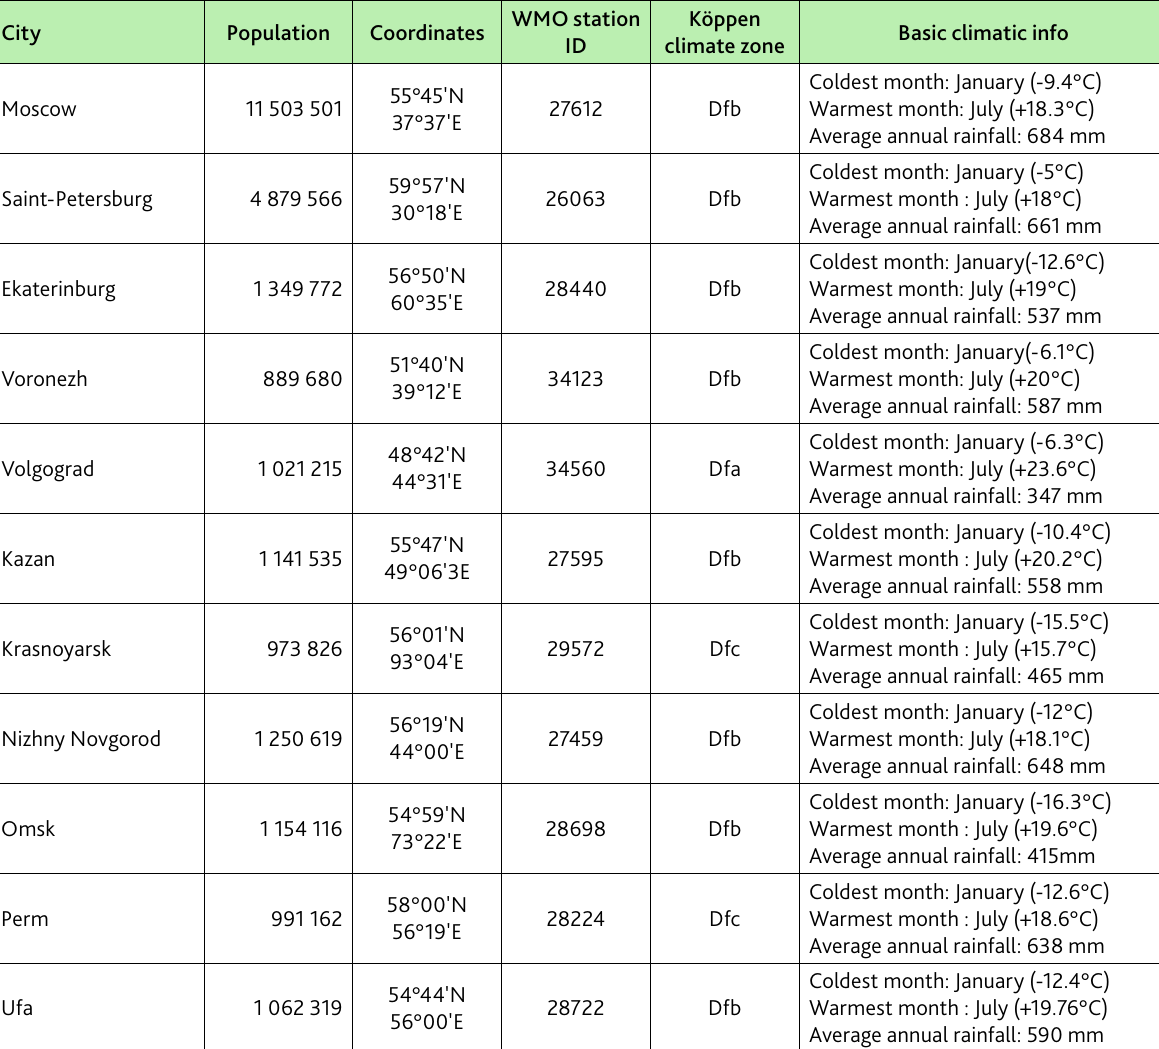
Table 1. Main big cities of Russian Federation: geographical overview (Bolshaya…, 2007; Census,